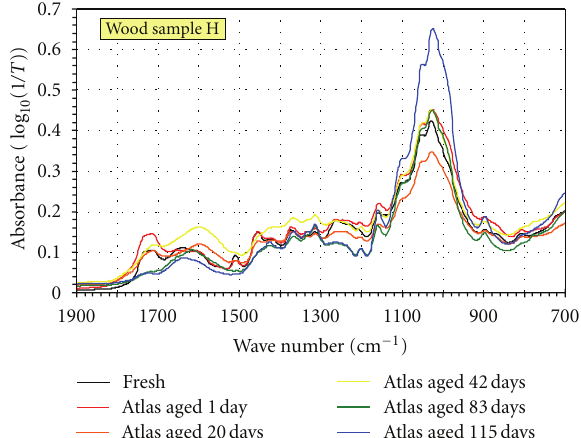
Figure 6: Absorbance (logarithmic) versus wave number between 1900–700 cm − 1 for wood sample H during accelerated ageing in an Atlas Solar Simulator.